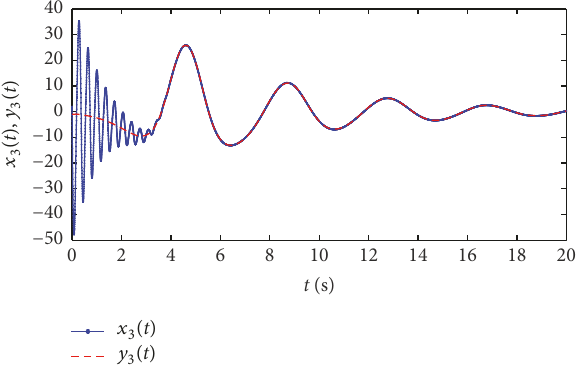
Figure 7: The controlled state trajectory of 𝑥 3 and 𝑦 3 .